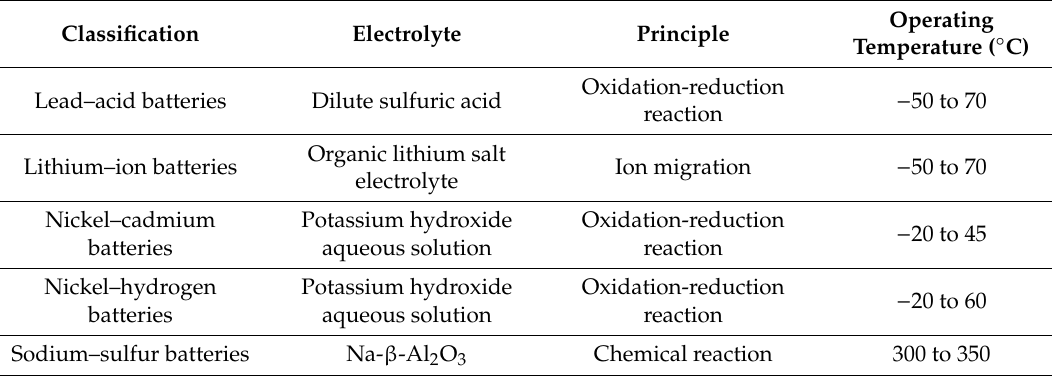
Table 5. Key performance comparisons of each